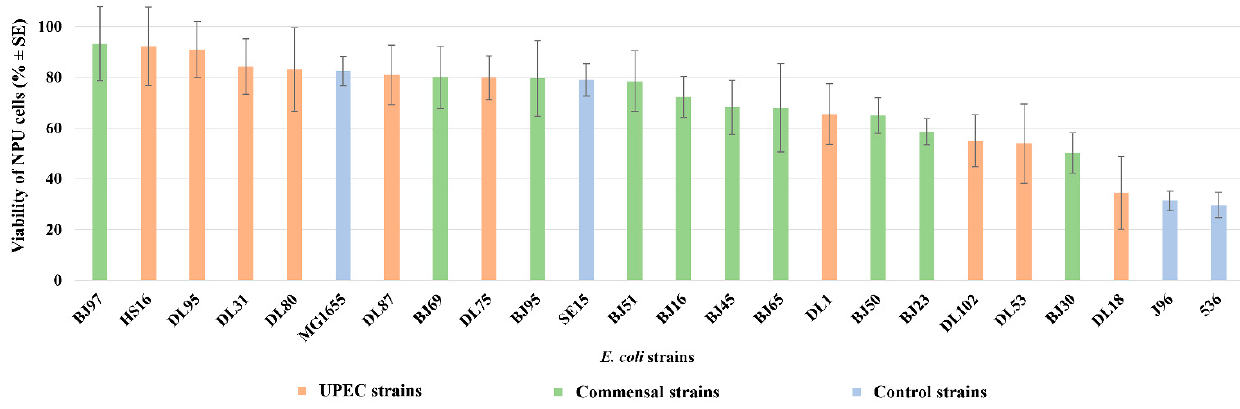
Figure 2. Viability of NPU cells infected with 20 different natural and a set of control pathogenic and non-pathogenic E. coli strains. Human E. coli strains isolated from the fecal samples of healthy individuals are designated as BJ, (green columns); human E. coli strains isolated from patients with urinary tract infection are designated as DL or HS (red columns); set of control pathogenic (J96, 536) and non-pathogenic (MG1655, SE15) E. coli strains (blue columns). Results were obtained on four biological samples in altogether from 5 to 22 independent experiments. Error bars represent standard error of the mean